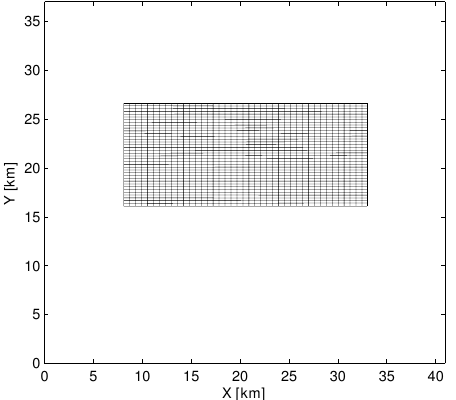
Figure 27. Discrete domain in plant view for the initial model for inversion of real salt structures.